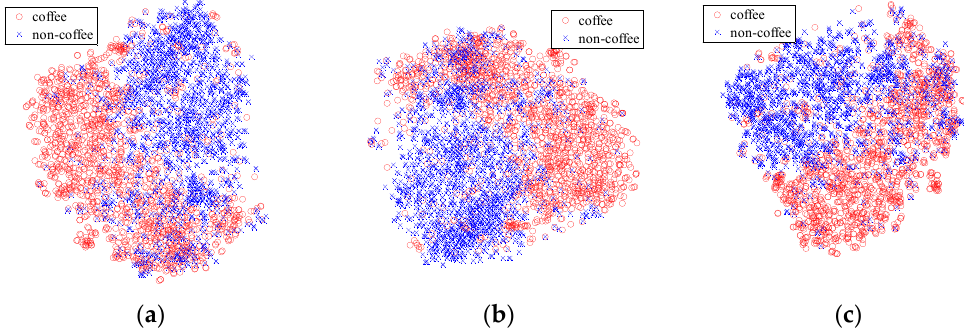
Figure 17. 2-D feature visualization of image global representations learned from Brazilian Coffee Scenes dataset in condition of: ( a ) Off-the-shelf; ( b ) Architecture (I); and ( c ) Architecture (II). The t-SNE algorithm proposed in [40,41] is used to visualize the high-dimensional representations.